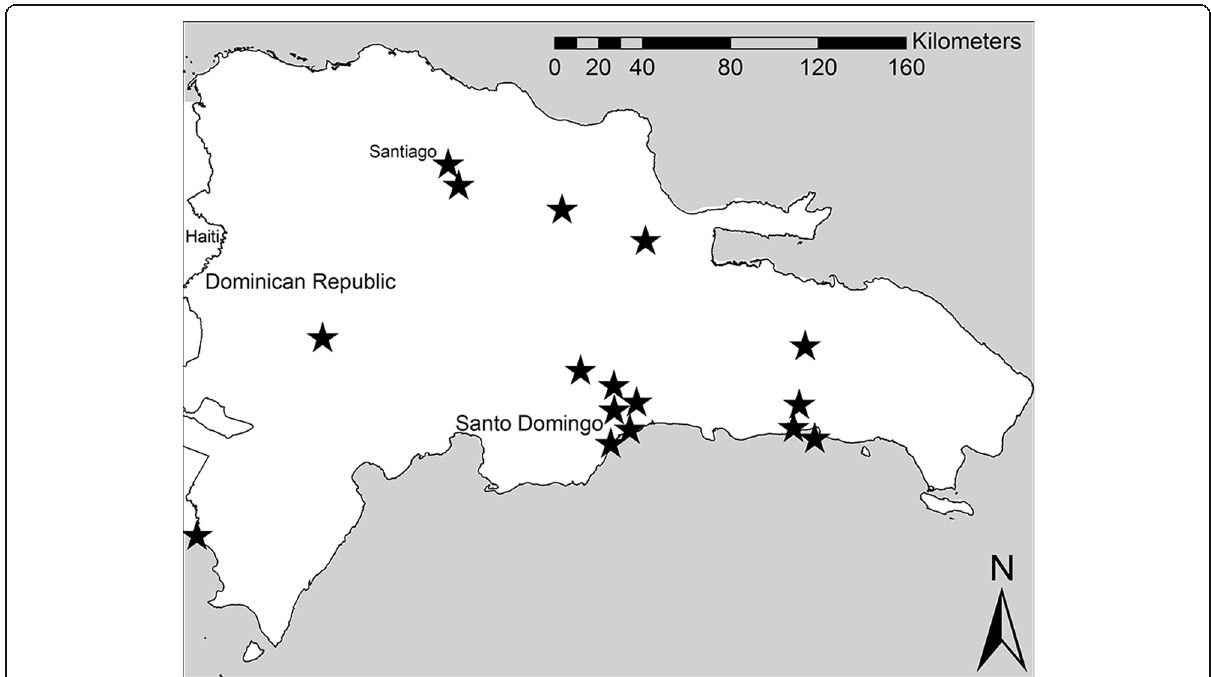
Fig. 1 Location of 16 selected villages in the Dominican Republic. Stars denote the approximate location of villages included in this study. Villages that were close in proximity were offset on the map to provide distinct representations for each